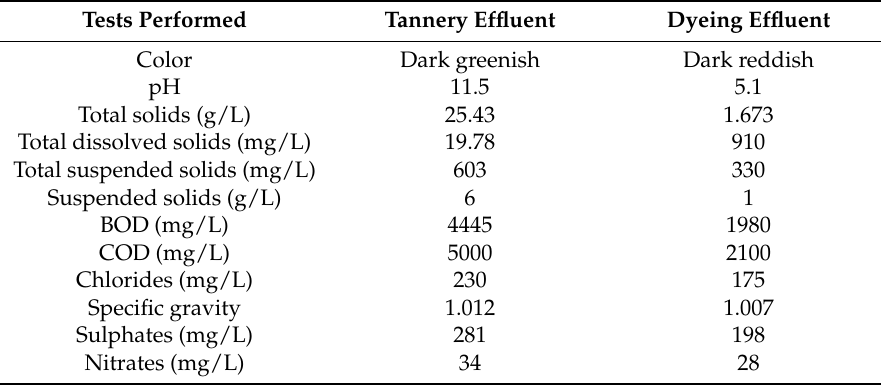
Figure 4. Effluent from tannery industry (Basic). Table 2. Properties of industrial effluents.